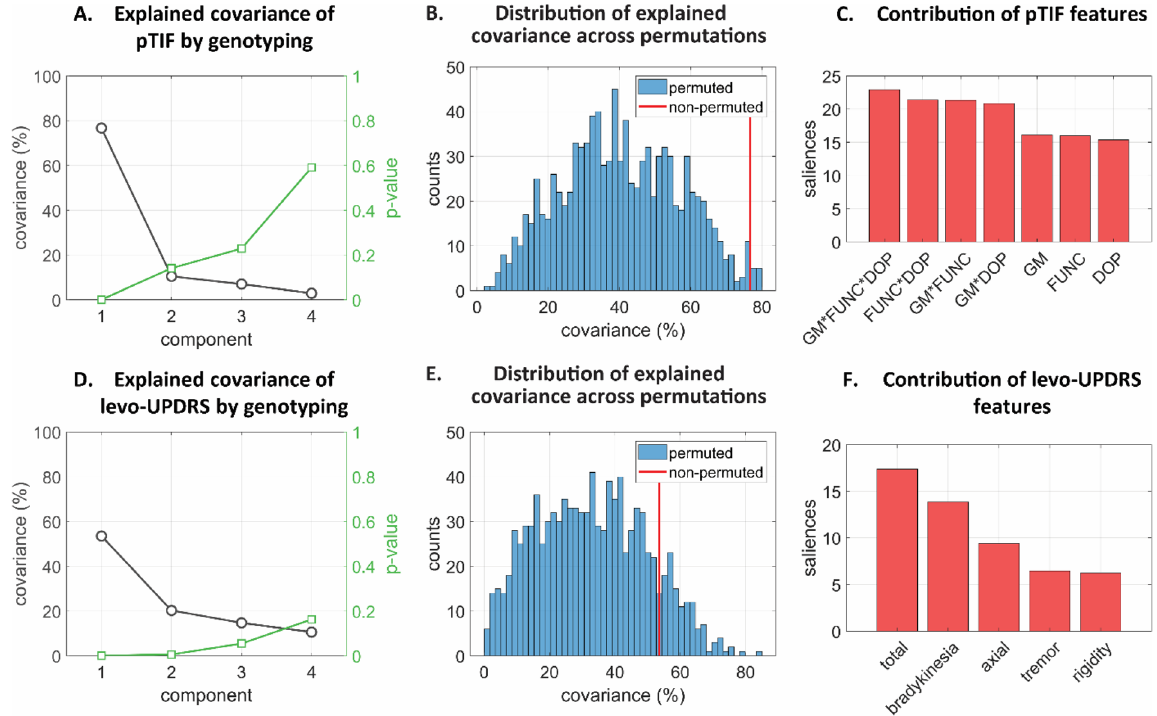
Figure 3. Multivariate cross-correlation results between genotyping and imaging-derived therapeutic needs. ( A ) Explained covariance of pTIF by genotyping for each principal component. ( B ) Distribution of explained covariance across randomized permutations for the first significant principal component (PC1). This was used to calculate the cross-validated added explained variance (the added value was defined as the difference between the original pTIF-genomics shared variance with the mean value of the randomized distribution). ( C ) Contribution of pTIF features in PC1. ( D ) Explained covariance of levodopa-induced UPDRS changes (levo- UPDRS) by genotyping for the obtained principal components. ( E ) Distribution of explained covariance across permutations for PC1. ( F ) Contribution of levo-UPDRS features in